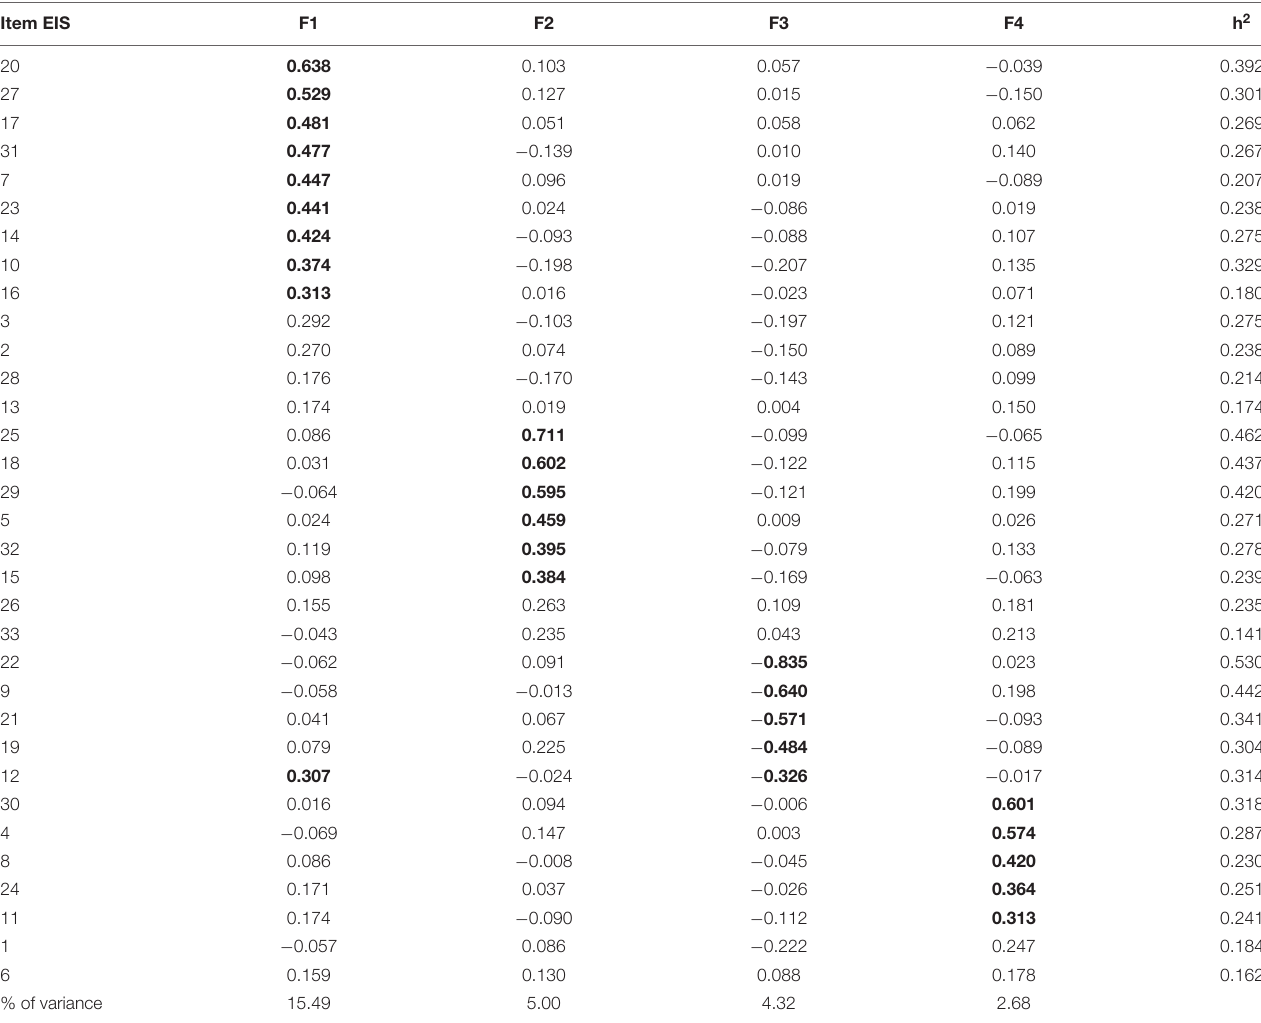
TABLE 2 | Factor loadings, communalities (h 2 ) and % of variance explained.